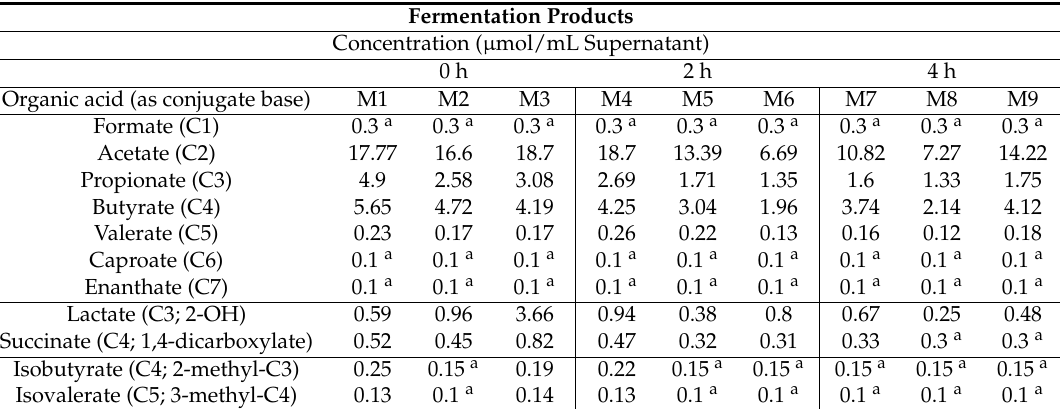
Table 2. Organic acid fermentation products from caecal contents of individual mice before (0 h) and after administration of resistant starch (RS; 2 h and 4 h). M1 to M9 identify the mouse source for caecal contents at each sampling time.